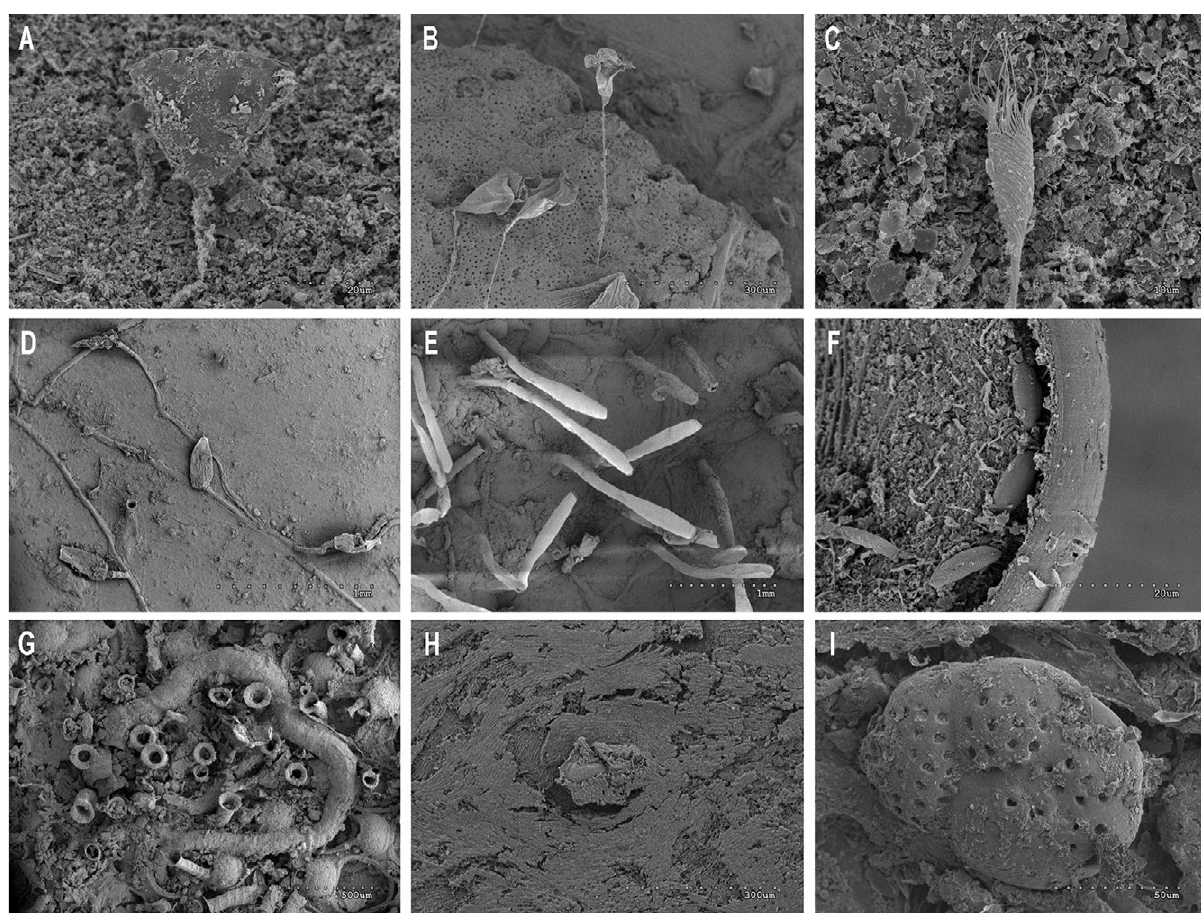
Fig. 6. – Organisms on benthic plastics. A, B, C, D, protozoans; E, hydrozoans; F, detail of benthic diatom living in hydrozoan; G, tube of polychaete; H, bryozoan colony; I,